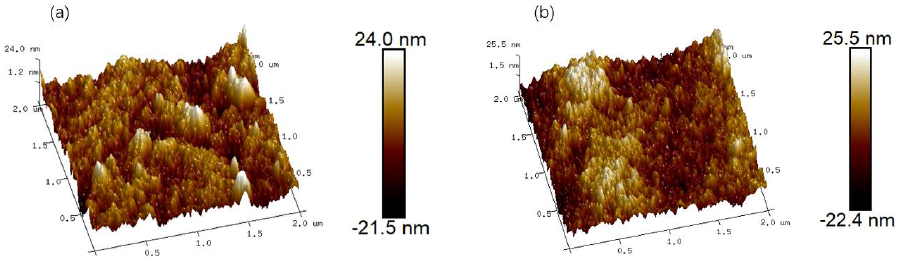
Figure 10. The surface AFM 3D images of the CA membrane ( a ) and CA/ZIF-8 membrane ( b ).